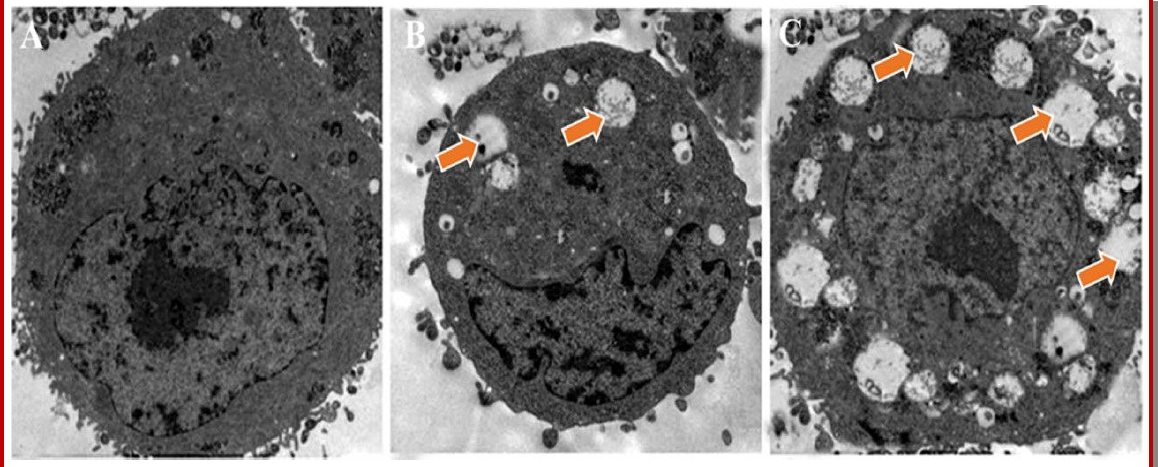
Figure 3: Evaluation of autophagy-induction by naringenin chalcone in U87MG human glioblastoma cells. The cells were treated with 0 µ Μ ( A), 50 µM (B) and 100 µ Μ ( C) dose of naringenin chalcone for 48 hours and then analyzed by Transmission Electron Microscopy. Arrows indicate autophagic vacuoles which were seen only in drug-treated cells